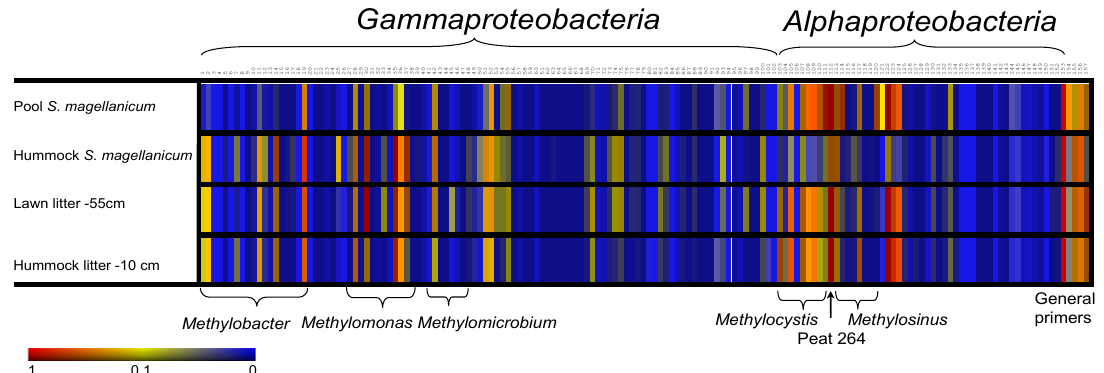
Fig. 3. Representation of the results for the pmo A based microbial methanotrophic community analysis using a pmo A microarray. All samples originate from the “high CH 4 ” bog. Colour coding bar on the right side represents achievable signal for an individual probe (1 indicates maximum signal obtained, 0.1 indicates 10% signal, i.e. only 10% hybridization to that probe and 0 indicates no signal). List of probes in the respective order is given in Supplementary Material Table